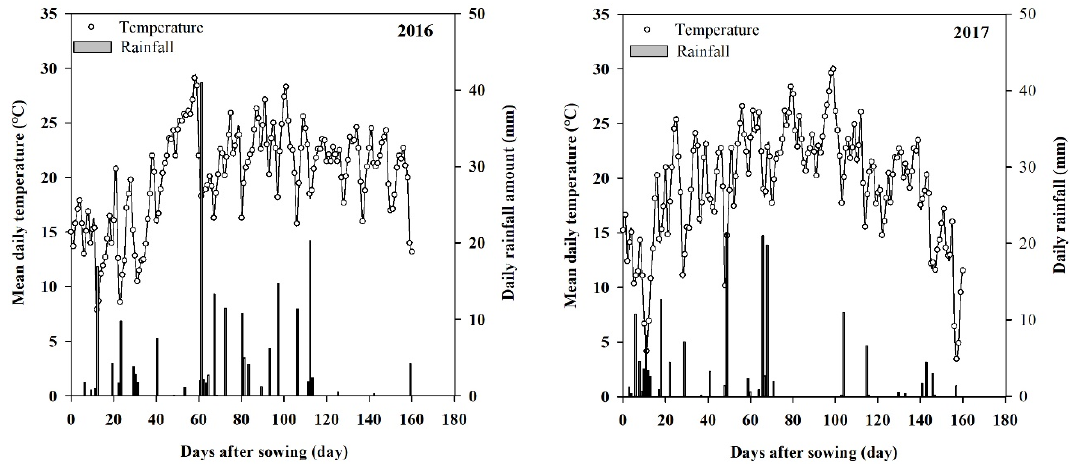
Figure 1. Precipitation and average air temperature in the maize growing season during 2016 and 2017.